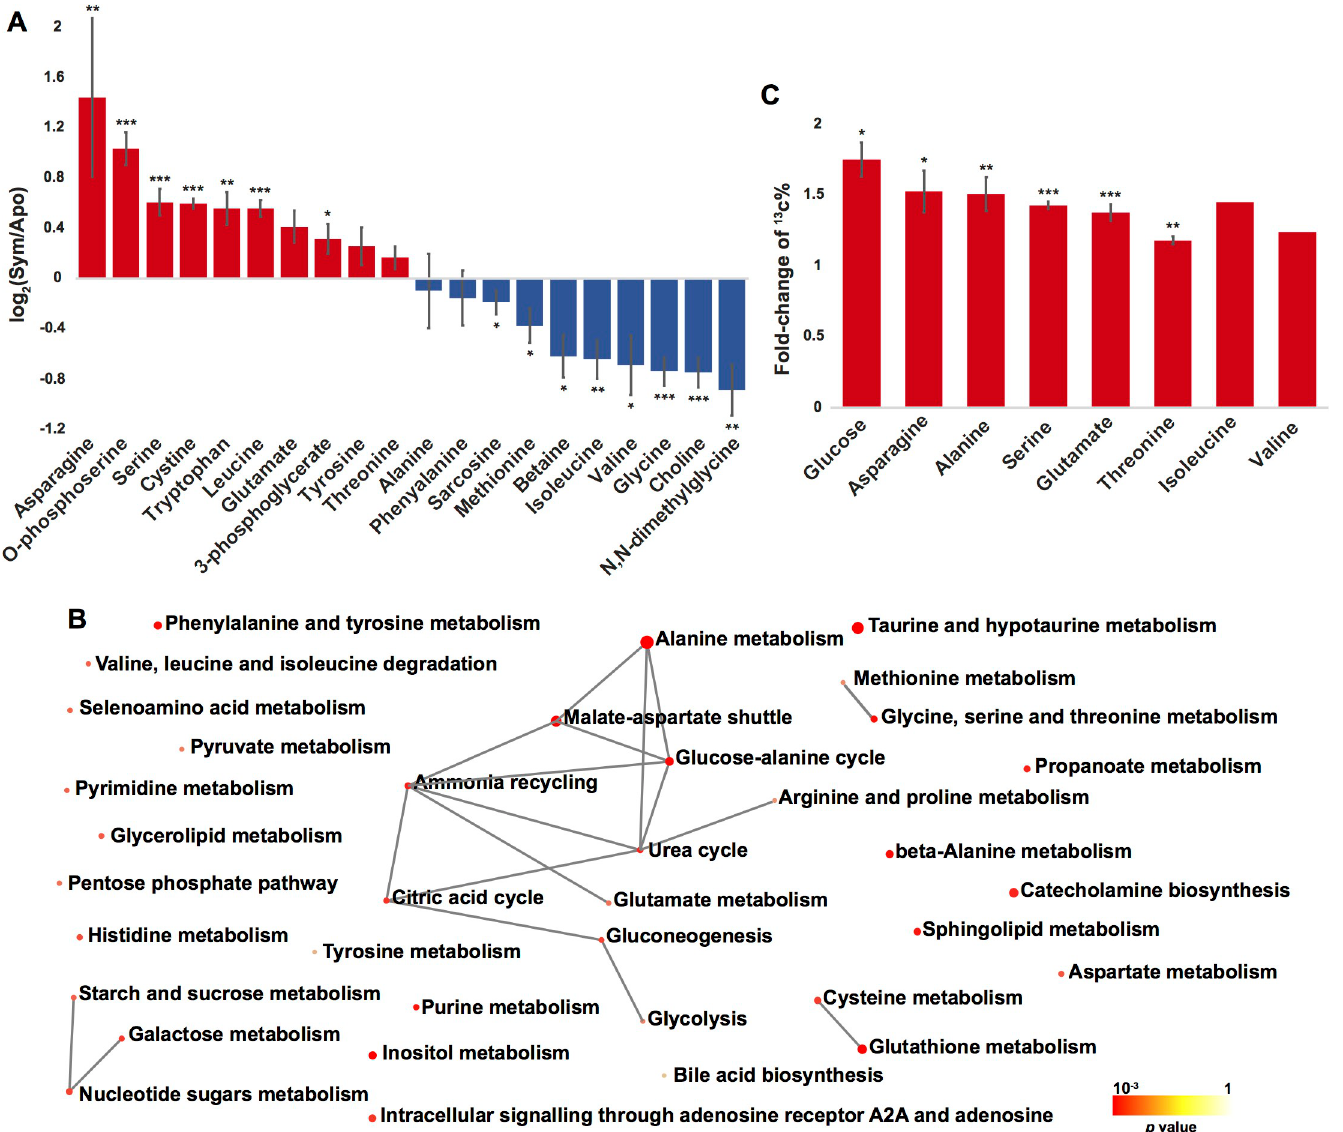
Fig 5. Change of Aiptasia metabolite profiles in response to symbiosis. (A) Metabolite abundance changes in response to symbiosis. Color represent abundance changes, with red for increases in symbiotic anemones, blue for increase in aposymbiotic animals. (B) Pathways associated with 13 C-enriched metabolites. (C) Increasing 13 C proportion of glucose and amino acids in symbiotic Aiptasia . Asterisks denote statistical significance of the changes (two-tail t test: � p < 0.05, �� p < 0.01, ��� p < 0.001). Statistical testing of isoleucine and valine was not possible as they were detected in only one aposymbiotic replicate with reasonable concentration. Error bar represents standard error of the mean.